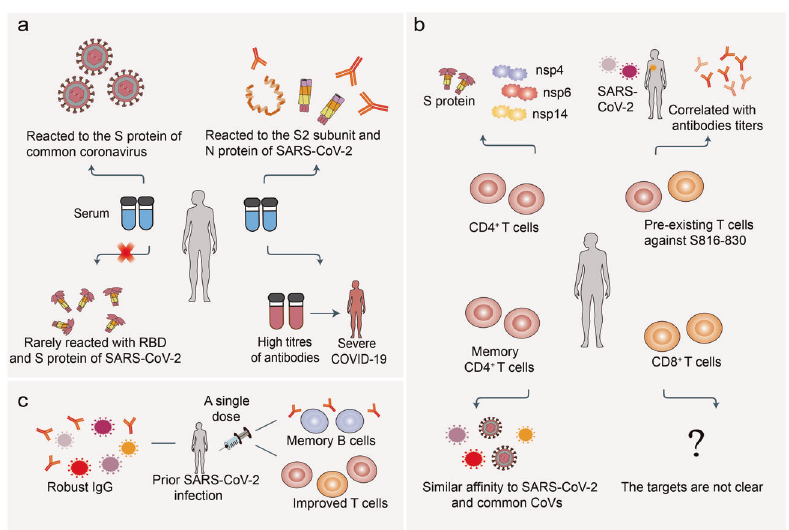
Fig. 5 a The target of pre-existing antibodies in SARS-CoV-2 unexposed individuals. The serum from SARS-CoV-2 unexposed individuals reacted to the S proteins of common coronavirus, with some antibodies against S2 subunit and N protein of SARS-CoV-2 and rarely against RBD. Moreover, high titers of pre-existing antibodies might correlate with severe COVID-19. b The target of pre-existing T cells. The cross- reactive CD4 + T cells mainly recognized the S protein and some non-structural proteins, but target proteins of CD8 + T cells are unknown. Pre- existing T cells against S816-830 correlated with levels of anti-SARS-CoV-2 antibodies. Furthermore, memory CD4 + T cells had a similar af fi nity to SARS-CoV-2 and common cold coronavirus. c Vaccination for individuals with prior-SARS-CoV-2 infection. A single dose of SARS-CoV-2 vaccine induced robust humoral and cellular immune responses in previously SARS-CoV-2-infected